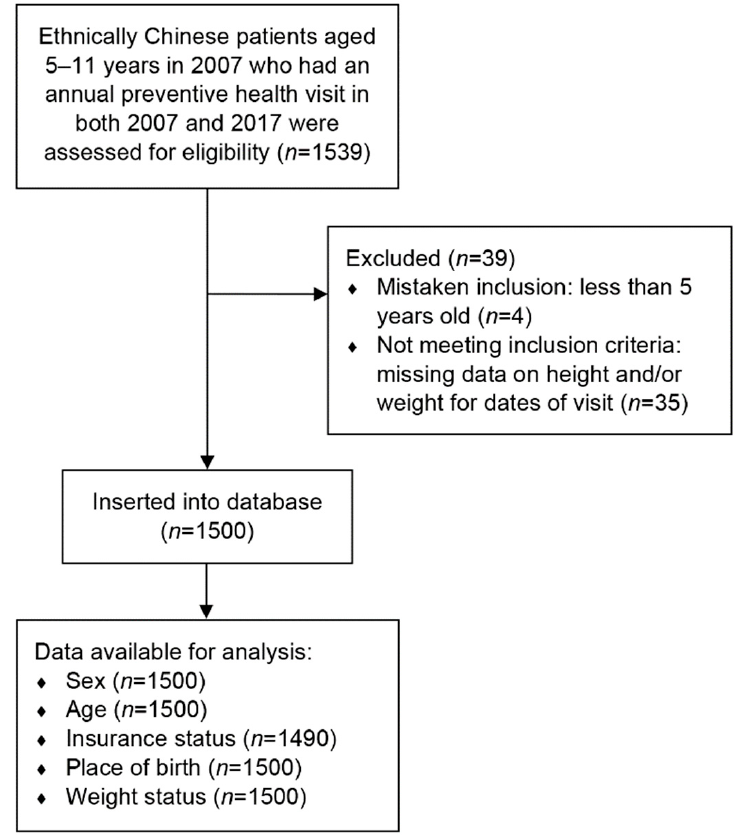
Figure 1. Study flow.